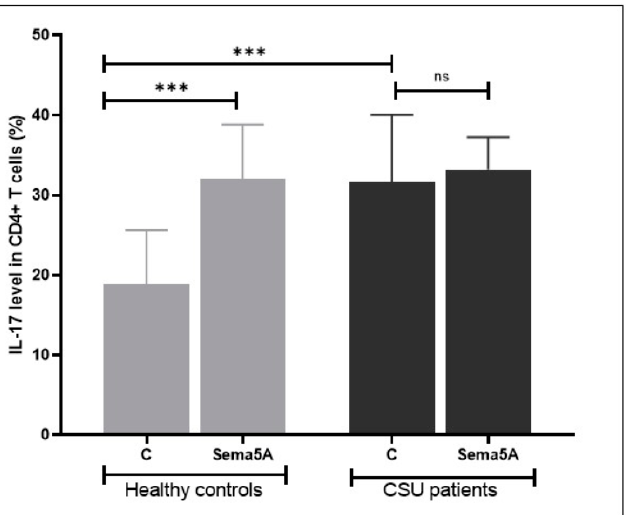
Figure 5. The effect of Sema5A on IL-17 expression in CD4+T cells. Patients with CSU have higher rates of IL-17-expressing CD4+ T cells as compared to healthy controls. Incubation with Sema5A “ns”—not significance, ***—statistically